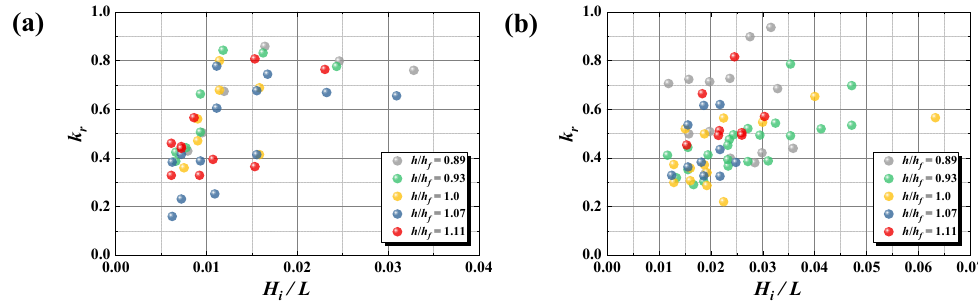
Figure 16. Relationship between H i / L and k r for ( a ) pattern E and ( b ) pattern A.